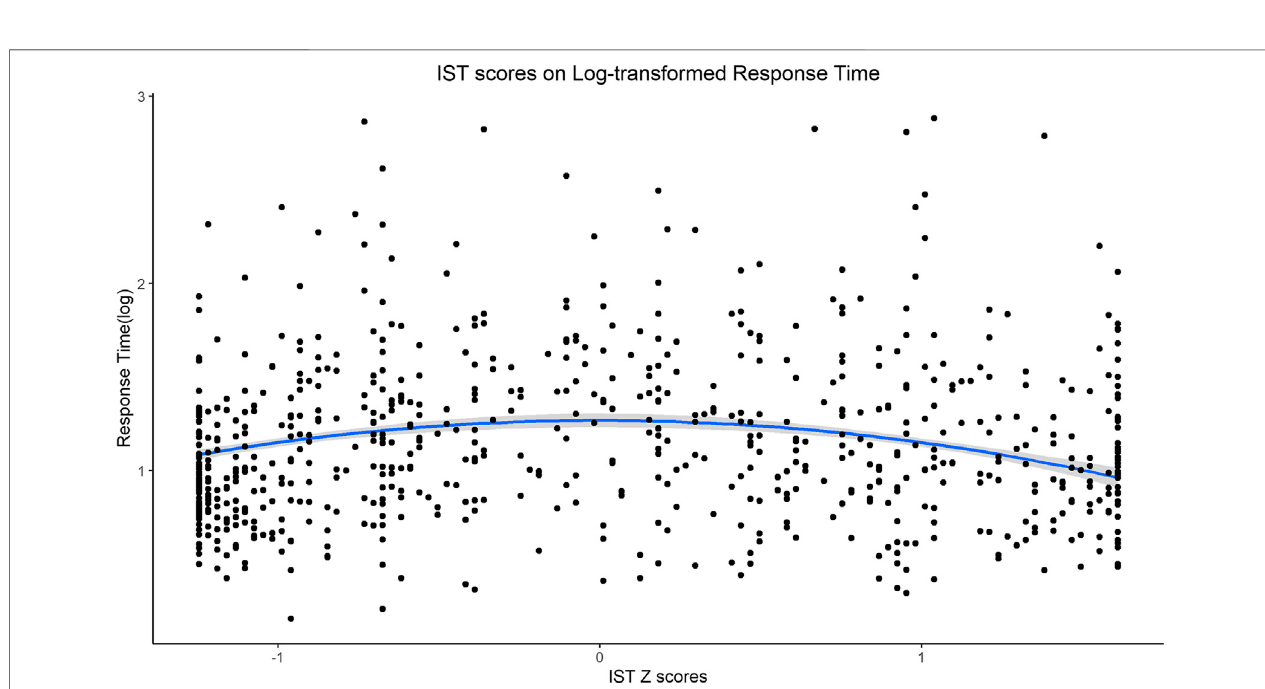
FIGURE 5 | LMM: statistically signi fi cant quadratic effect of the IST-z score on log-transformed response time showing faster RTs for extreme scores.